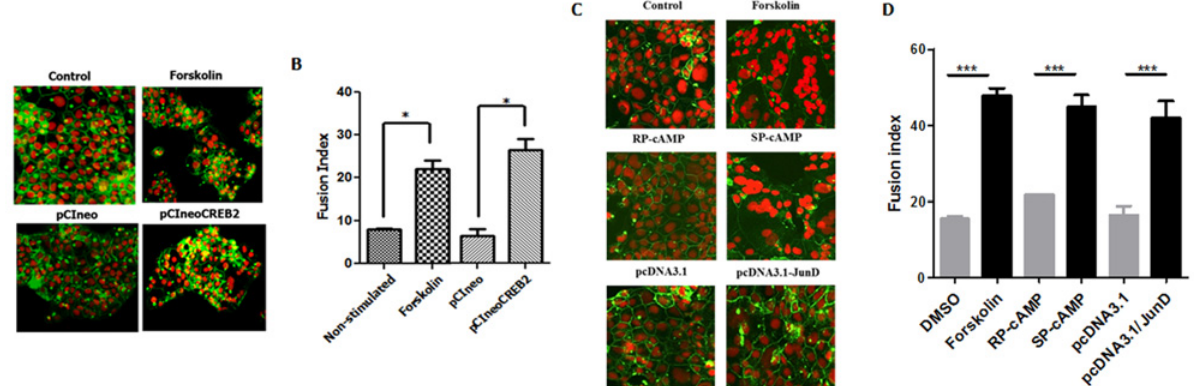
Fig 7. CREB2 and JunD overexpression induce BeWo fusion. BeWo cells were either left untreated (Control) or stimulated with forskolin or SP-cAMP (vs. its control, RP-cAMP) ( C-D ). In parallel, BeWo cells were transfected with expression vectors for JunD or CREB2 (or corresponding empty vectors) (200 ng). At 48 h post-transfection or post-stimulation, cell fusion was analyzed with anti-desmoplakin antibodies for membrane staining (green) and propidium iodide for nuclei staining (red). Images were visualized by confocal microscopy. (B, D) Cell fusion index was calculated in stimulated or transfected cells as follow: a total of 200 nuclei were counted in five independent fields per condition (average total of 1000 nuclei) and a percentage was calculated for the number of nuclei comprised in syncytia. These results are representative of a three different experiments ( * p < 0.05; *** p <